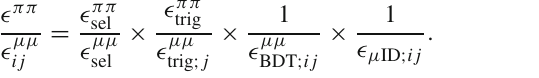
Table 2 Relevant systematic uncertainties on the branching fraction. They are separated, using horizontal lines, into relative uncertainties on (i) α ij , (ii) on the signal yield from the signal model used in the mass fit, and (iii) on the branching fraction, obtained combining the two categories, from the background